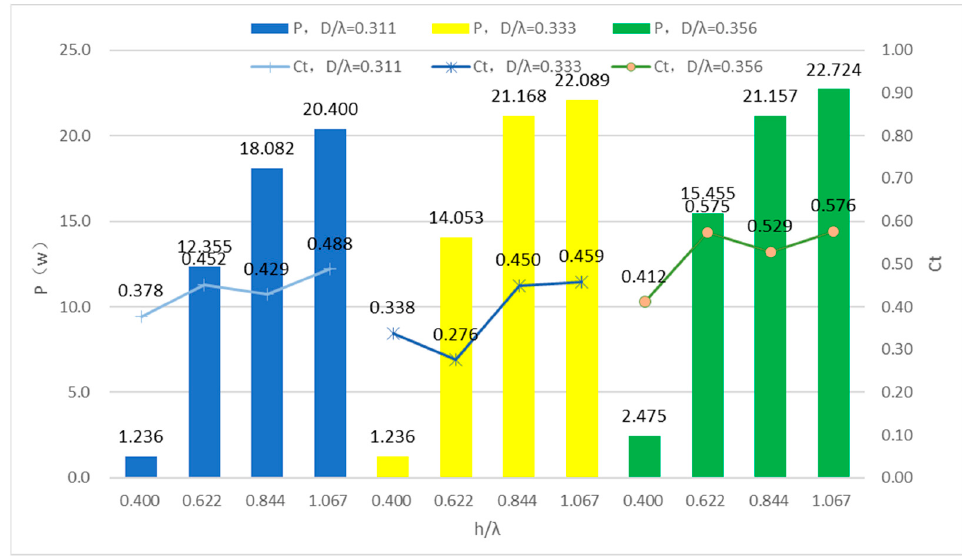
Figure 10. Physical experiment data map.